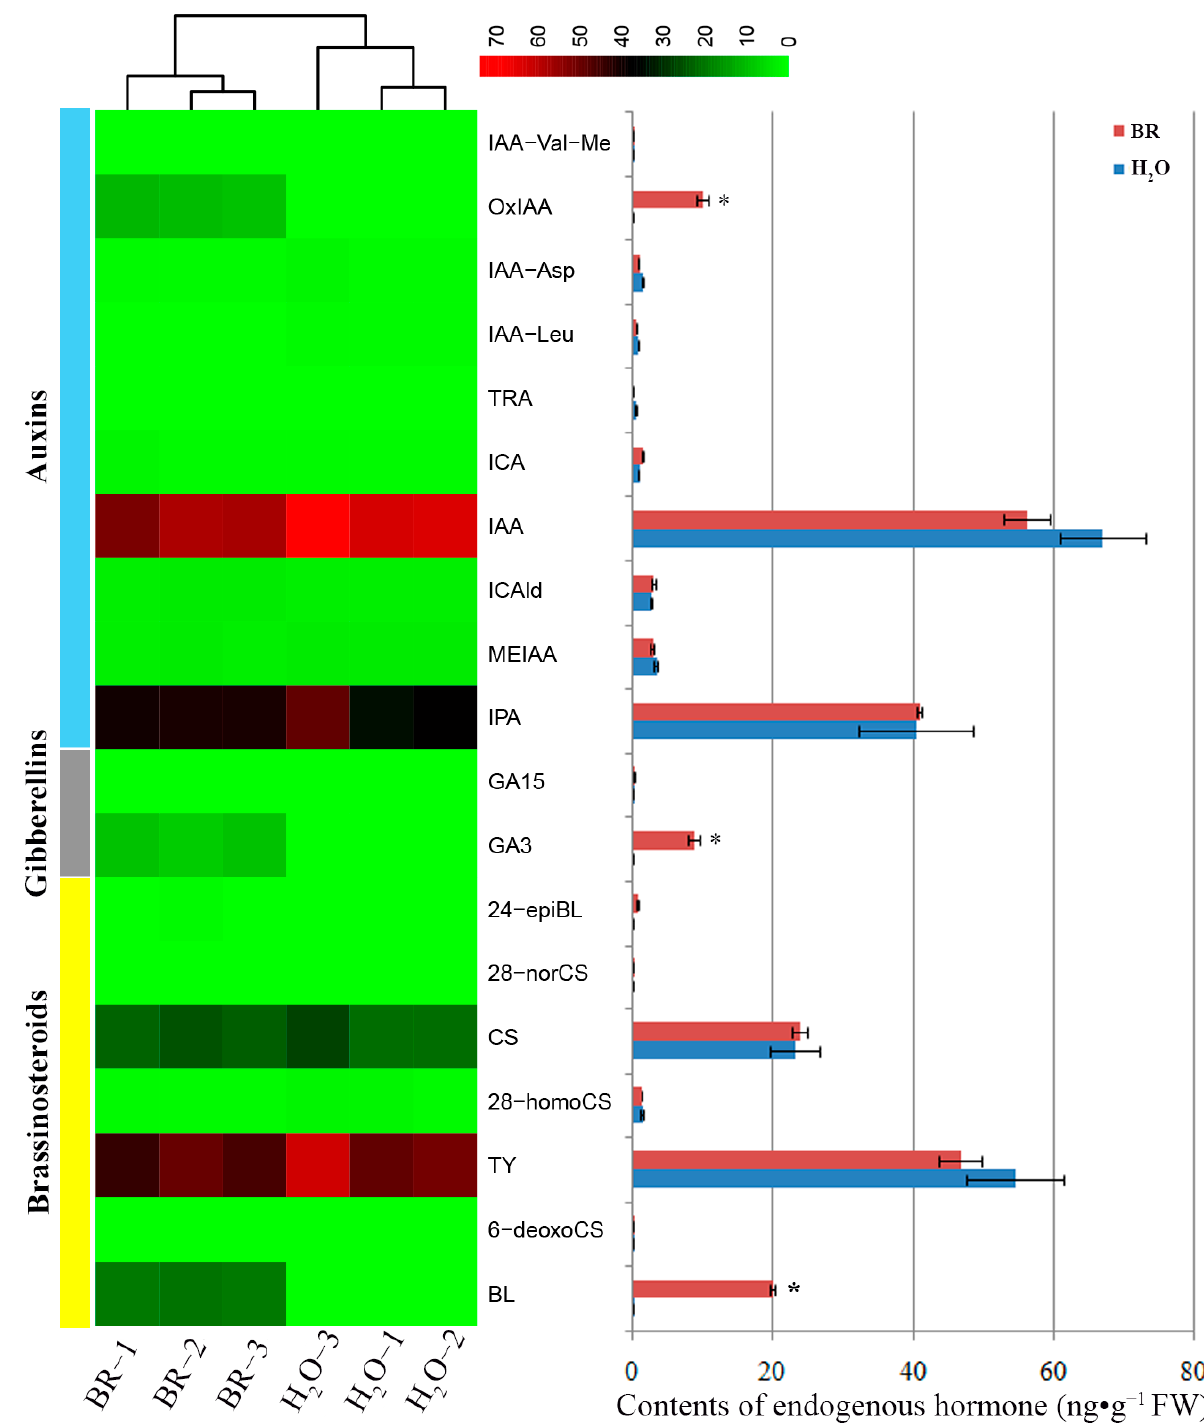
Figure 3. Endogenous hormone levels of the seedling stems after 1 mg · L − 1 BR and H 2 O treatment. FW means fresh weight. Error bars ± SE. * indicates significant differences in comparison with control at p < 0.05. The color brightness represents the degree of the content difference, as shown in the color bar. IAA-Val-Me: indole-3-acetyl-L-valine methyl ester; OxIAA: 2-oxindole-3-acetic acid; IAA-Asp: indole-3-acetyl-L-aspartic acid; IAA-Leu: N-(3-Indolylacetyl)-L-leucine; TRA: tryptamine; ICA: indole-3-carboxylic acid; IAA: indole-3-acetic acid; ICAld: indole-3-carboxaldehyde; MEIAA: methyl indole-3-acetate; IPA: 3-indolepropionic acid; GA15: gibberellin A15; GA3: gibberellin A3; 24-epiBL: 24-epibrassinolide; 28-norCS: 28-norcastasterone; CS: castasterone; 28-homoCS: 28-homocastasterone; TY: typhasterol; 6-deoxoCS: 6-deoxocastasterone; BL: brassinolide.